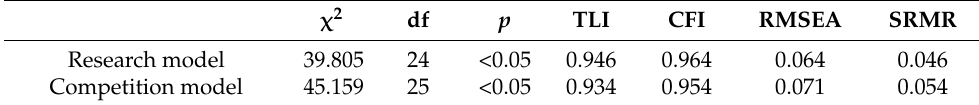
Table 3. Comparison of fit indices between the research model and the competition model.